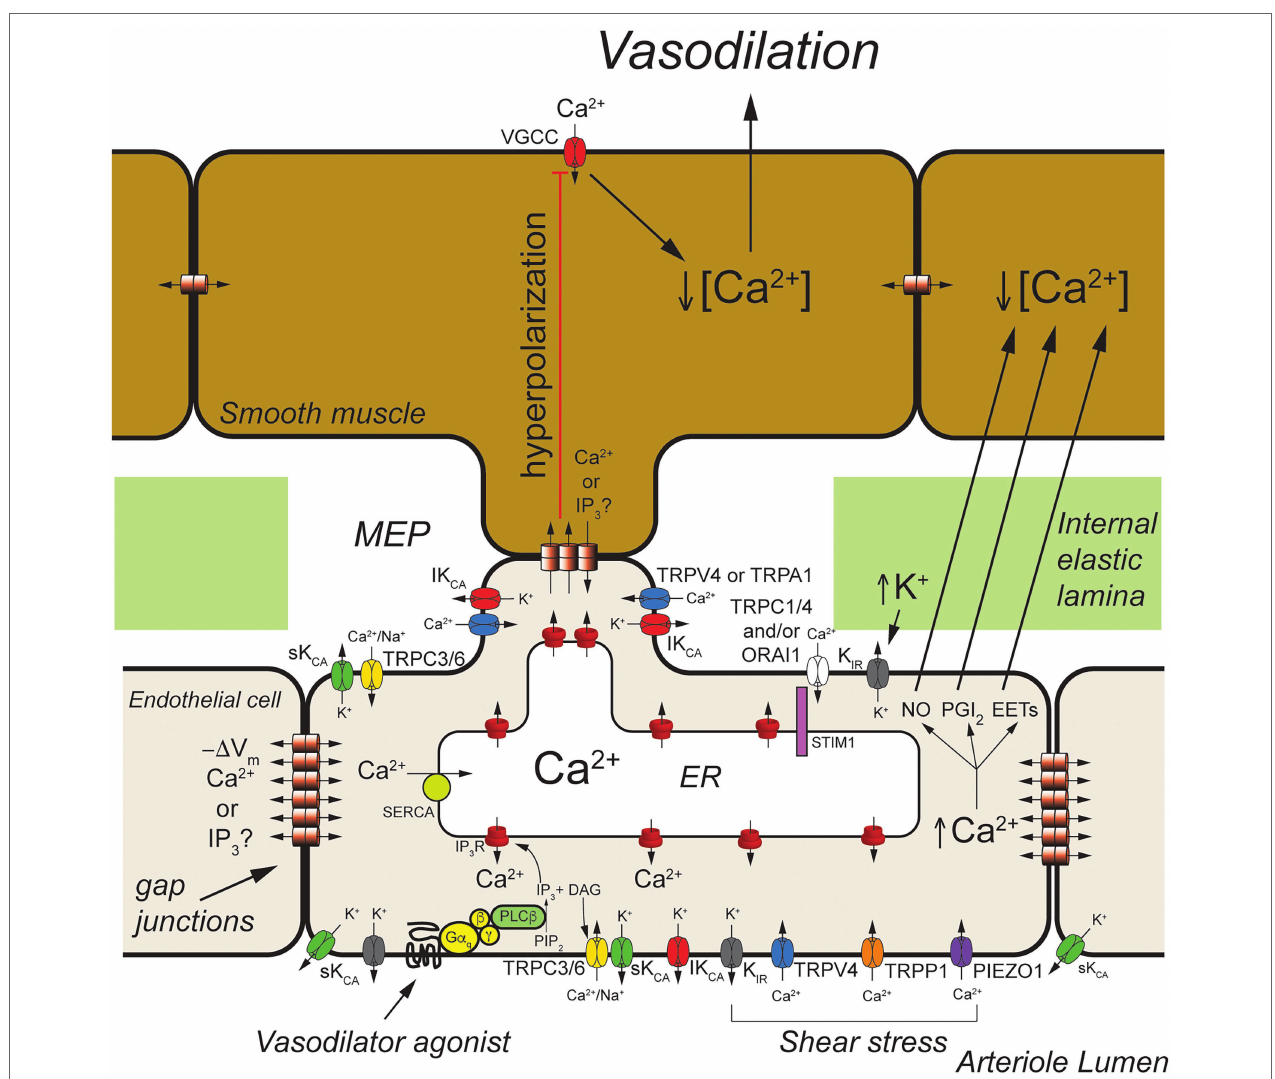
FIGURE 2 | Arteriolar endothelial ion channels and cell-cell communication. Shown is a schematic representation of a longitudinal cross-section through one wall of an arteriole showing cross-sections of endothelial cells and overlying smooth muscle cells. Endothelial cells communicate with overlying smooth muscle cells at myoendothelial projections (MEPs) that pass through the internal elastic lamina to make contact with overlying smooth muscle cells, as shown. Gap junctions may form at MEPs to yield myoendothelial gap junctions (MEGJs) allowing endothelial cell hyperpolarization to be conducted to the smooth muscle cells, closing smooth muscle voltage-gated Ca 2+ channels (VGCCs), decreasing [Ca 2+ ] in , and leading to vasodilation. At MEPs transient receptor potential vanilloid family member 4 (TRPV4), intermediate conductance Ca 2+ -activated K + (IK Ca ) channels and inositol 1,4,5 trisphosphate receptors (IP 3 R) are clustered forming signaling complexes to direct the endothelial cell responses to vasodilator agonists. In cerebral arteries/arterioles, transient receptor potential ankyrin family member 1 (TRPA1) is also in these complexes. Other ion channels, such as transient receptor potential C family member 3 (TRPC3) channels and small conductance Ca 2+ -activated K + (SK Ca ) channels, may cluster elsewhere to form other signaling complexes. Endothelium-dependent vasodilators, such as acetyl choline, act on G α q -coupled receptors to activate phospholipase C- β (PLC β ) which hydrolyses membrane phosphatidylinositol 4,5-bisphosphate (PIP 2 ) forming IP 3 and diacylglycerol (DAG). The IP 3 activates IP 3 Rs to release Ca 2+ from the ER increasing [Ca 2+ ] in . The DAG activates membrane TRPC3 and TRPC6 channels which serve as receptor-operate channels conducting Na + and Ca 2+ into the cells. DAG also activates protein kinase C (PKC; not shown) which phosphorylates and activates TRPV4 channels. Calcium influx through TRPV4 channels acts on IP 3 -sensitized IP 3 R, amplifying Ca 2+ influx through the TRPV4 channels. At MEP, the increase [Ca 2+ ] in results in activation of IK Ca channels causing membrane hyperpolarization ( −Δ V m ) that is transmitted through MEGJs to hyperpolarize overlying smooth muscle causing vasodilation. Transient receptor potential C family members 1 and 4 (TRPC1 and TRPC4), and ORAI1 channels are activated upon release of Ca 2+ from the endoplasmic reticulum (ER) via IP 3 Rs that is sensed by stromal interaction molecule 1 (STIM1) in the ER membrane. Inward rectifier K + (K IR ) channels (likely K IR 2.1) are expressed and can be activated by membrane hyperpolarization to facilitate hyperpolarization induced by SK Ca and IK Ca channels. They also are activated by increases in extracellular K + and involved with sensing shear stress. Shear stress also appears to activate TRPV4 channels, transient receptor potential polycystin family member 1 (TRPP1) channels, and PIEZO1 channels leading to increased endothelial [Ca 2+ ] in and vasodilation. In addition to activating SK Ca and IK Ca channels to produce hyperpolarization-induced vasodilation, increased endothelial cell [Ca 2+ ] in also results in production of endothelial cell vasodilator autacoids, such as nitric oxide (NO), prostacyclin (PGI 2 ), and epoxides of arachidonic acid (EETs) that cause arteriolar vasodilation. See text for additional information and